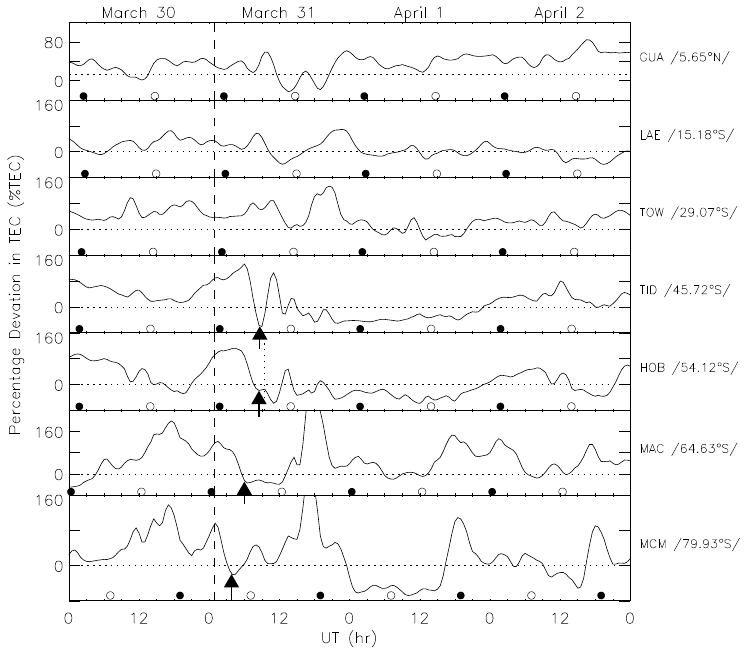
Fig. 3. Temporal profile of percentage deviation of storm-time TEC, relative to quiet days (three-day average), during 30 March to 2 April at all chains of stations. Vertical dashed line indicates SSC time. Open and solid circles on the time axis correspond to local midnight and noon,